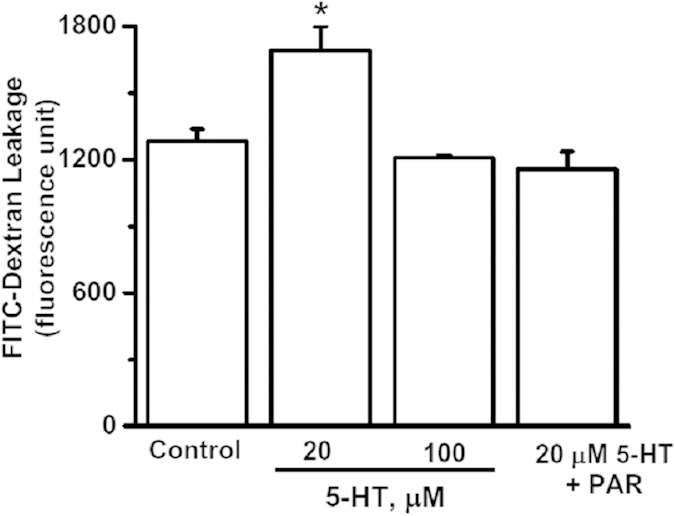
Effects of 5-HT on extravasation of FITC-dextran from murine endothelial cells in vitro.Endothelial cells (2 × 105 cells/assay) grown on Transwell-COL 24 mm diameter 0.04 μm pore size plates inserts were either treated with 5-HT or together PAR and 5-HT or proceed to the assay directly without treatment as control. FITC-dextran (40 kDa) was introduced into the upper compartment and the lower compartment was sampled after 45 min. 5-HT (20 μM) revealed a significant 1.32-fold increase in leakage in the absence of other serum factors. However, in the presence of PAR, 5-HT pretreatment was not effective. Data are mean ± SD, n = 10 replicates; *p < 0.05 compared to Control.